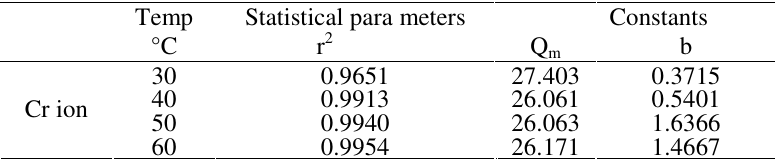
Table 3. Langmuir isotherm Results